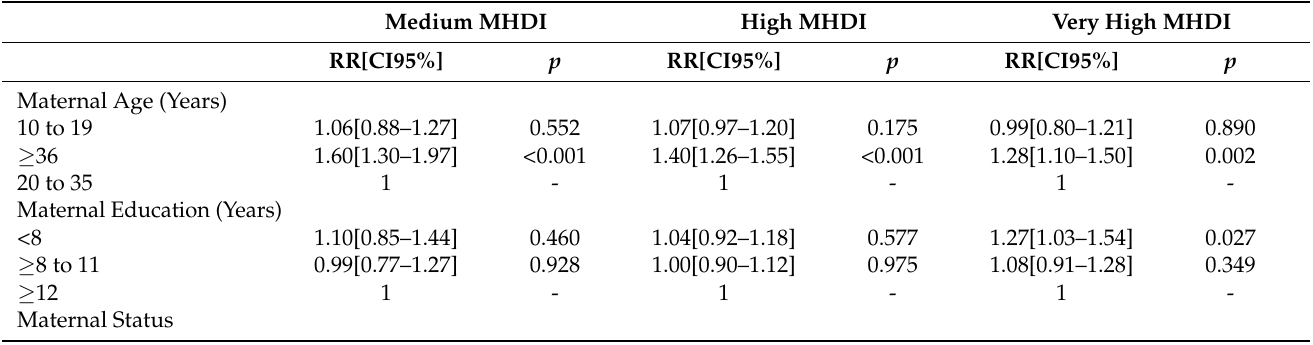
Table 2. Association of sociodemographic, perinatal, and neonatal characteristics on congenital anomaly according to the MHDI classification in Porto Alegre from 2000 to 2017 (adjusted